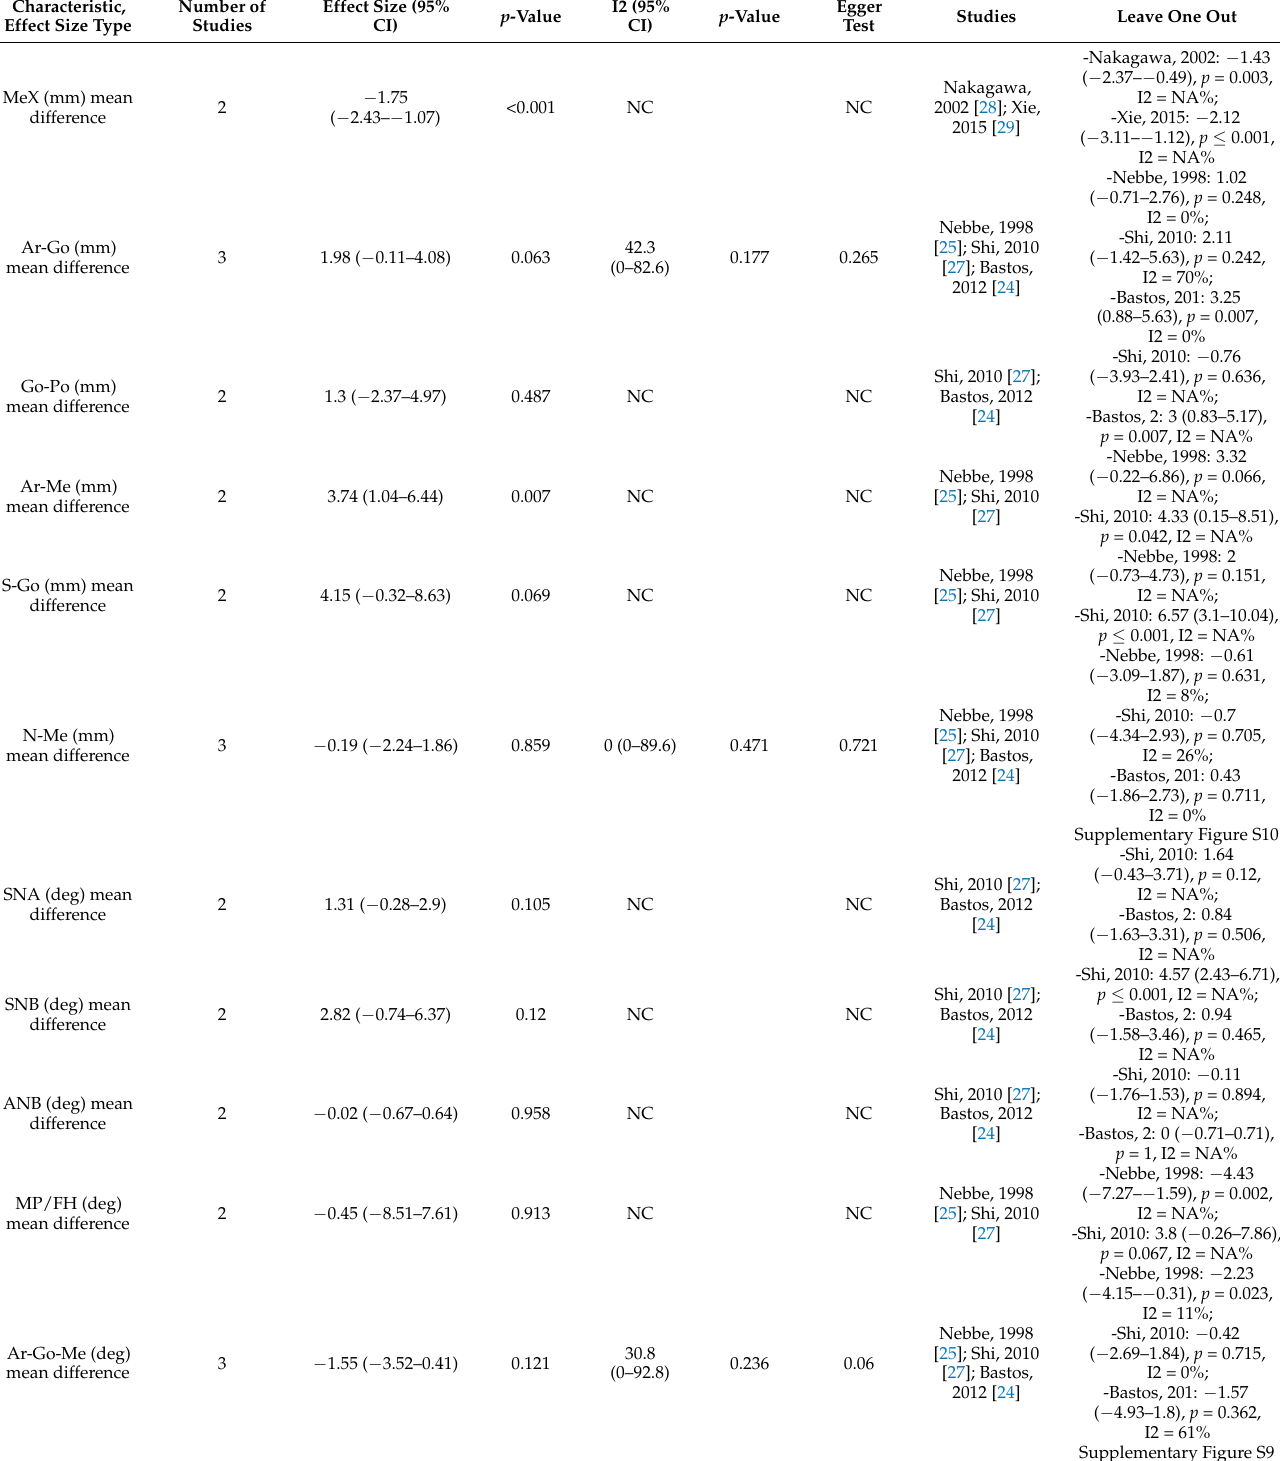
Table 2. Meta-analyses